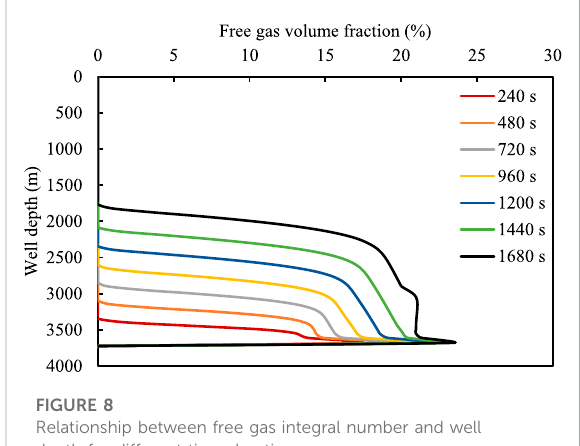
FIGURE 10 Variation in the mud pit increment with time for different gas types and